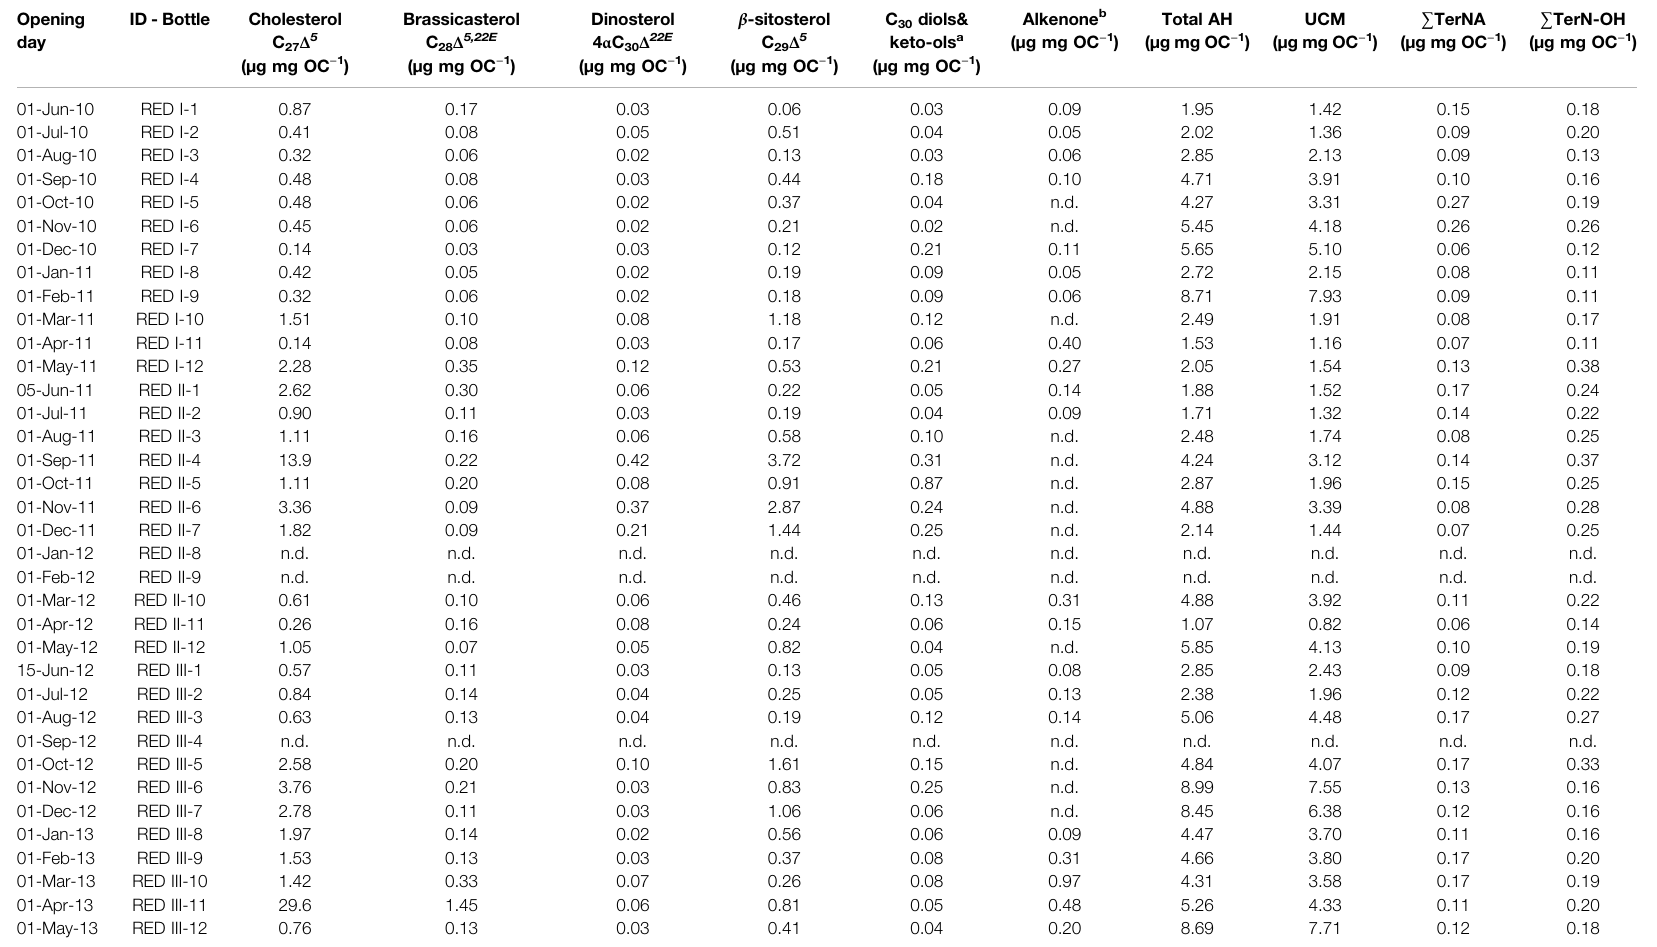
TABLE 2 | POC-normalized concentrations of selected lipid biomarkers (n.d.: no data). Opening